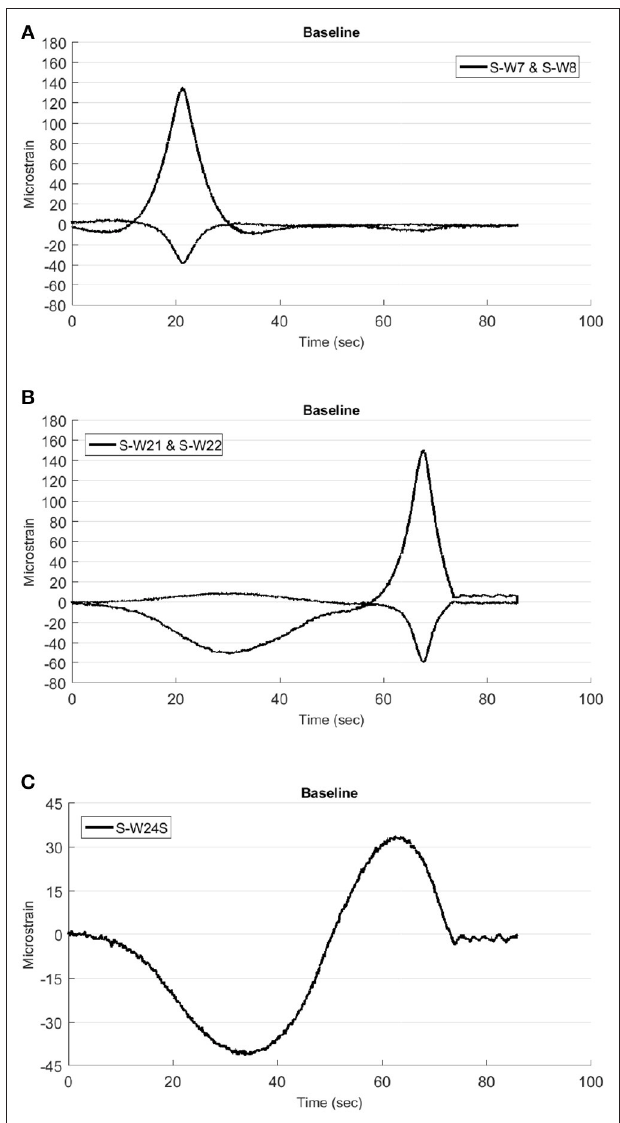
FIGURE 4 | Baseline strain time histories for six truck pass: (A) midspan; (B) controlling location; (C) pylon.